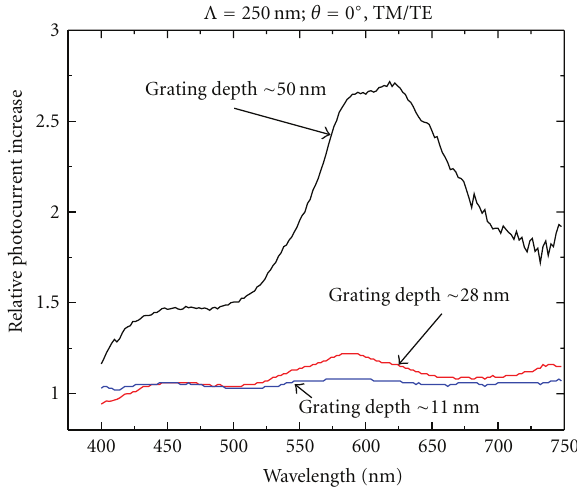
Figure 9: The relative photocurrent responses of P3HT-PCBM layer as a function of wavelength at normal incidence for gratings with Λ = 250nm and at various